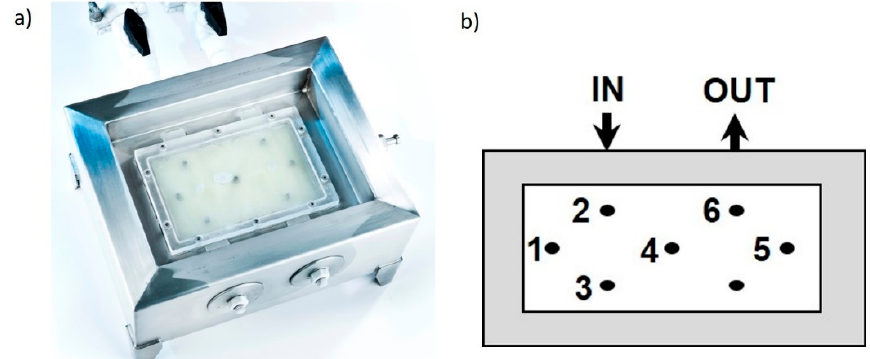
Figure 1. ( a ) Actual freezing chamber of the freezing unit with respective temperature probes inside the chamber; ( b ) sketch of the chamber and location of temperature probes.